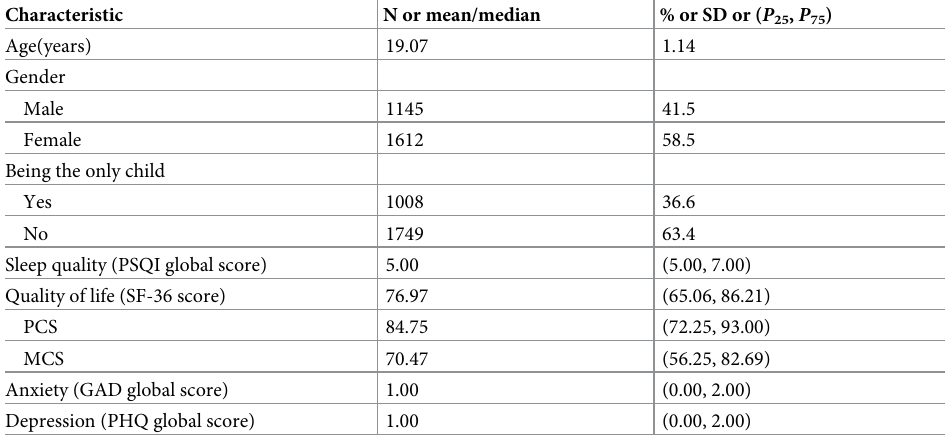
Table 1. Demographic characteristics of study participants.